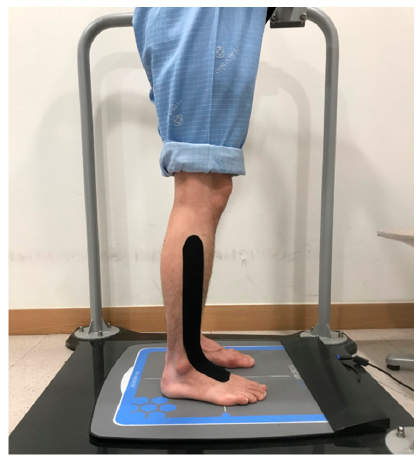
Figure 1. Tibial muscle taping.